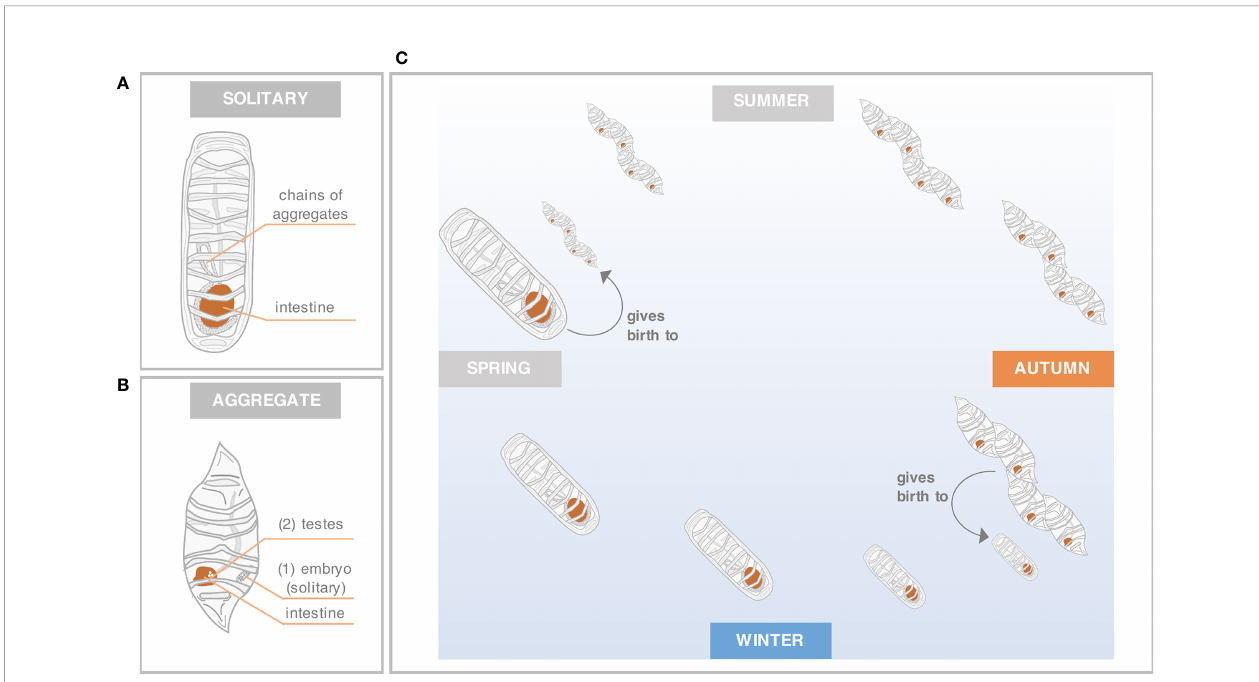
FIGURE 1 | Forms and seasonal life cycle of S. thompsoni . Basic anatomy and reproductive features are shown for solitary (A) and aggregate (B) forms. Aggregates are characterized by their protogynous hermaphroditic nature, fi rst they develop the ovary/embryo (1) and later the testes (2). The seasonal life cycle [ C ; modi fi ed from Loeb and Santora (2012)] re fl ects simpli fi ed seasonal migration, development and reproduction based on Foxton (1966) and Casareto and Nemoto